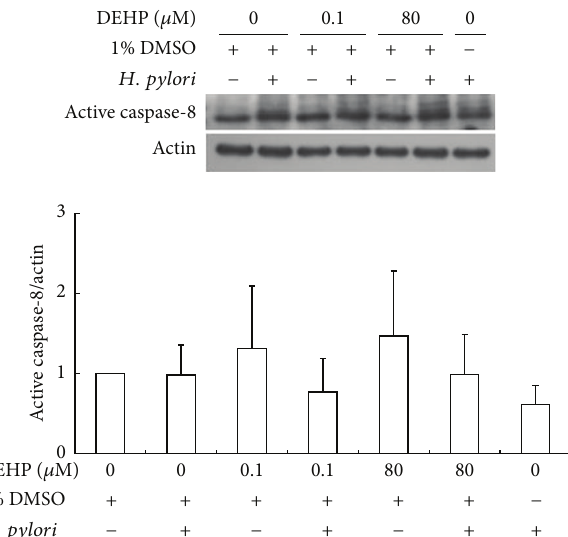
Figure 5: The effect of DEHP and H. pylori on active caspase-8 protein expression after 18-hour treatment. Statistical significance was analyzed by one-way ANOVA and post hoc LSD test ( 𝑁 = 3